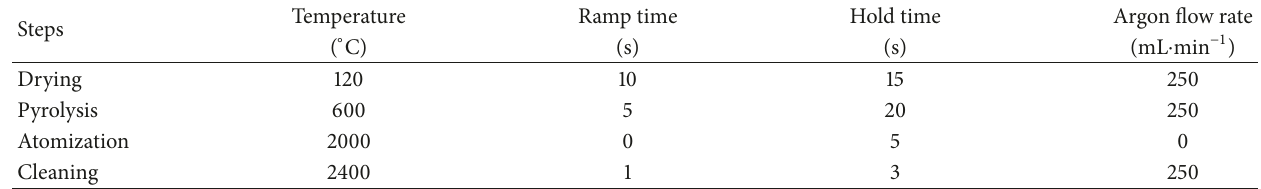
Table 1: Graphite furnace atomizer temperature-rising